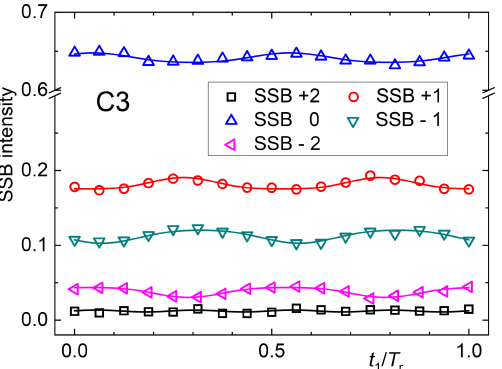
Figure 8. SSB oscillations along t 1 of carbon C3.